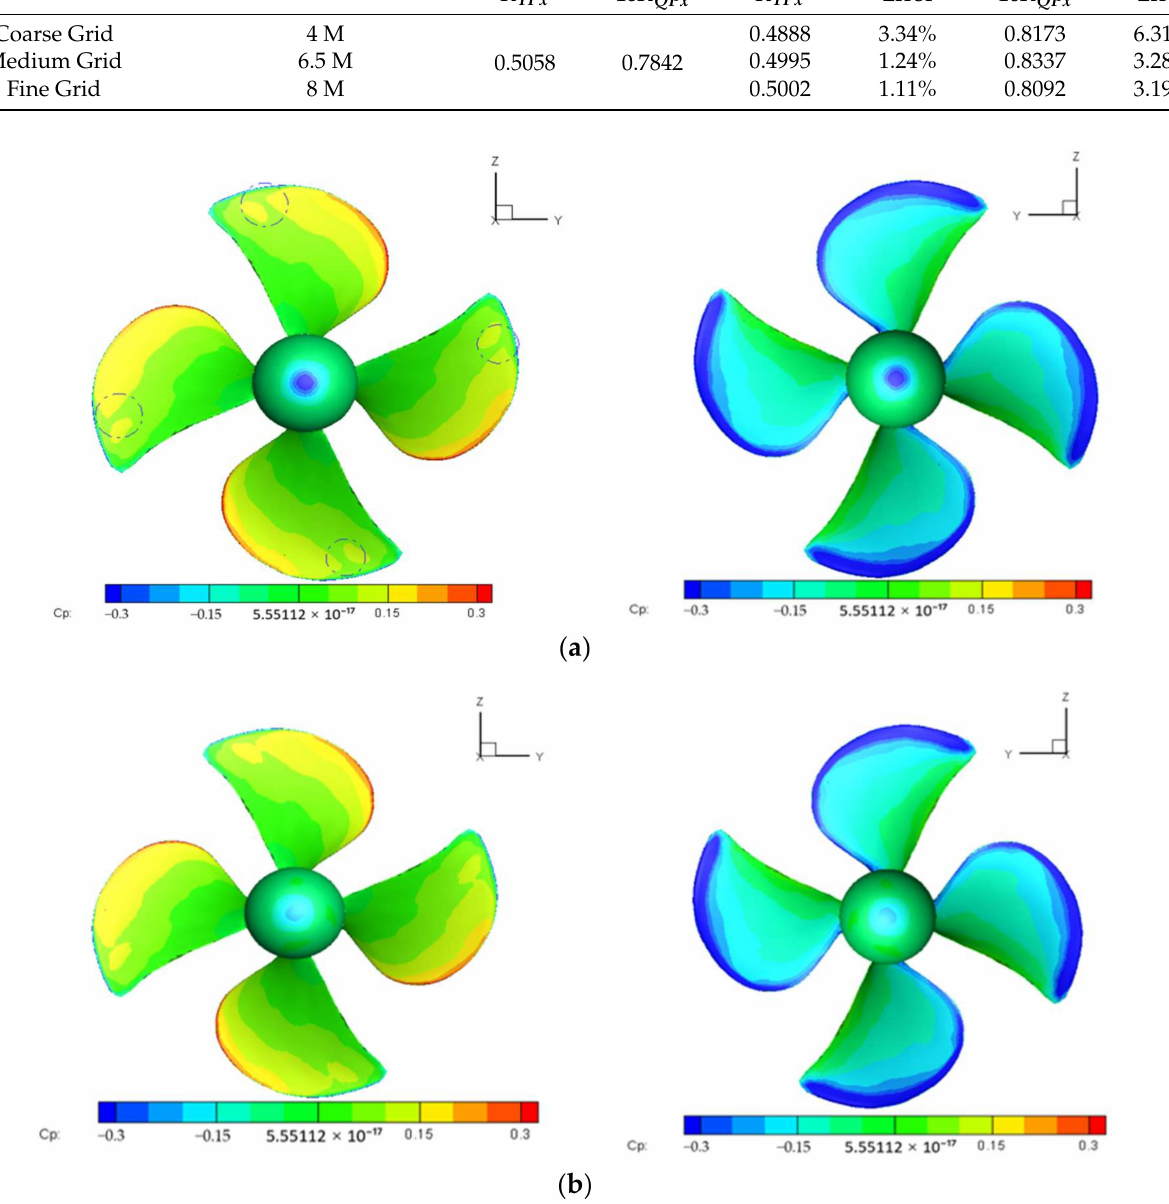
Figure 9. Pressure distribution on the propeller surface: ( a ) Medium Grid ( b ) Fine